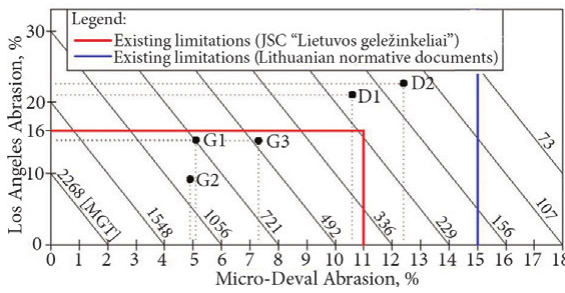
Fig. 5. Lifespan prognostic graphic model of ballast aggregate as sleepers are made of Table 2. Division of ballast aggregate mechanical properties categories